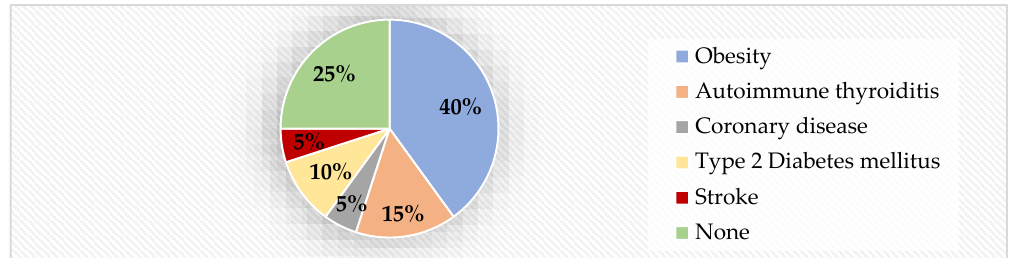
Figure 3. Family history of risk factors, in obese children.